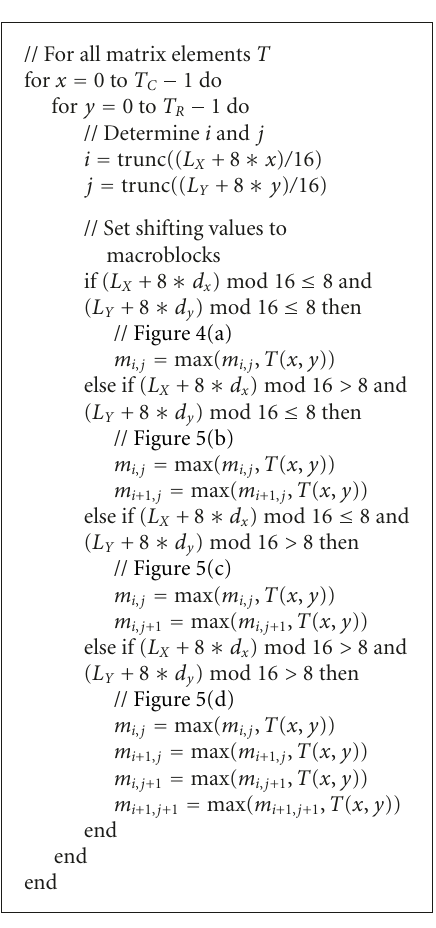
Algorithm 7: Determine shifting values for all